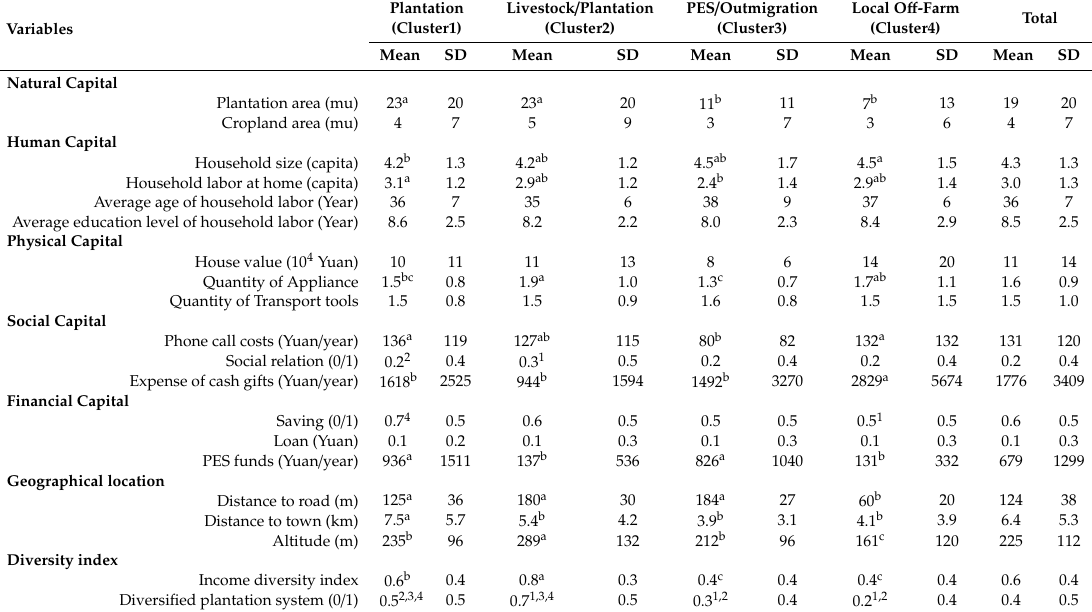
Plantation (Cluster1)